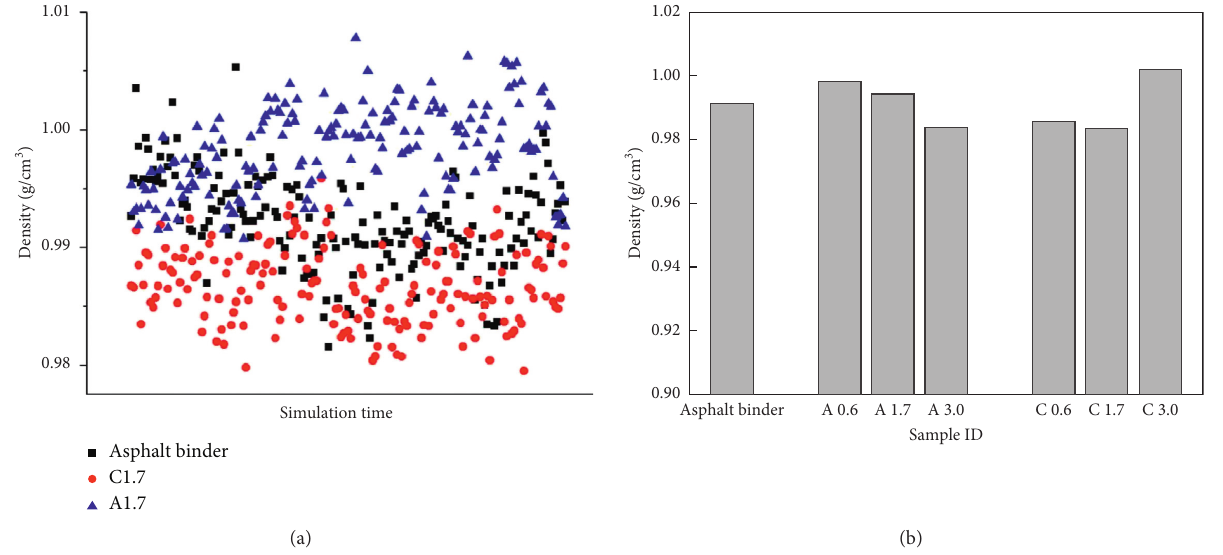
Figure 6: (a) The simulated density values of three kinds of samples; (b) the average density results.